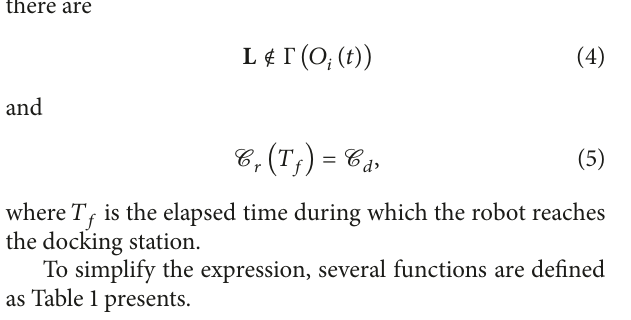
󳨀→ 𝑉 1 and ends at